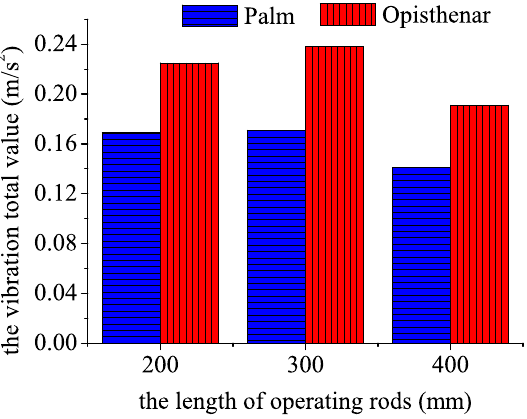
Figure 2. Comparison of the vibration total value generated by different types of operating rods.